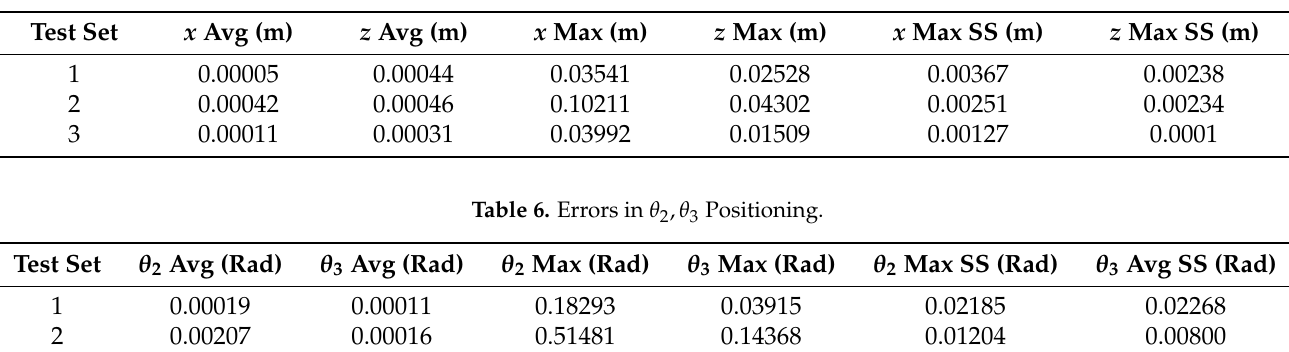
Table 5. Errors in x , z Positioning.